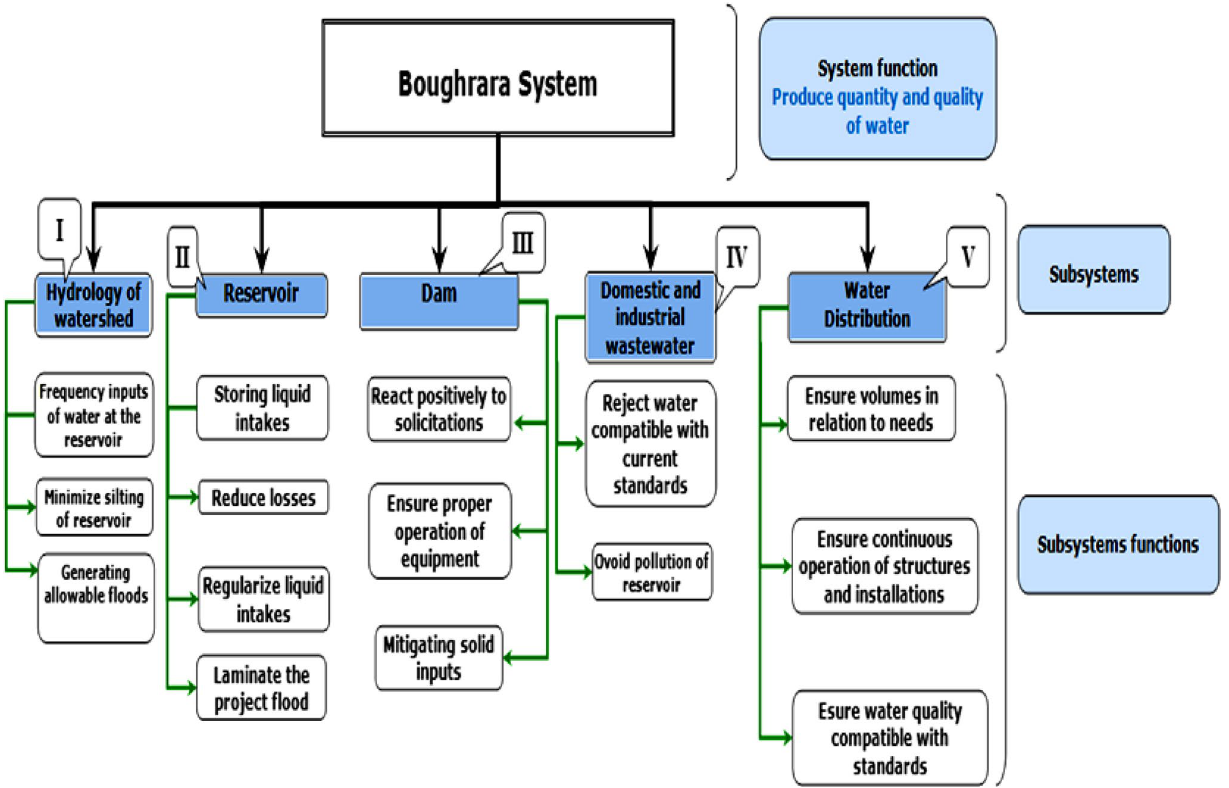
Fig.4 Functional decomposition of the